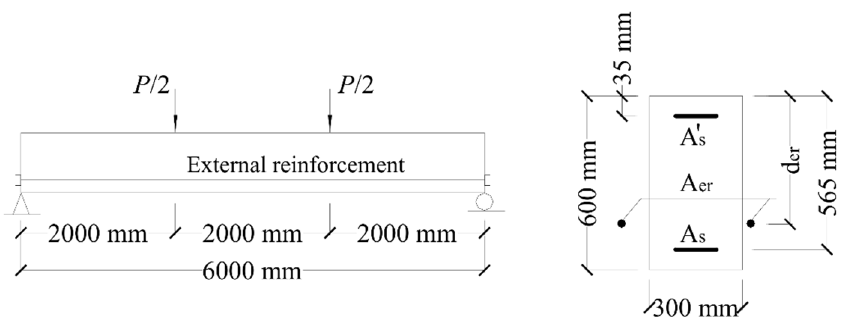
Figure 5. Details of the beams used for numerical evaluation.